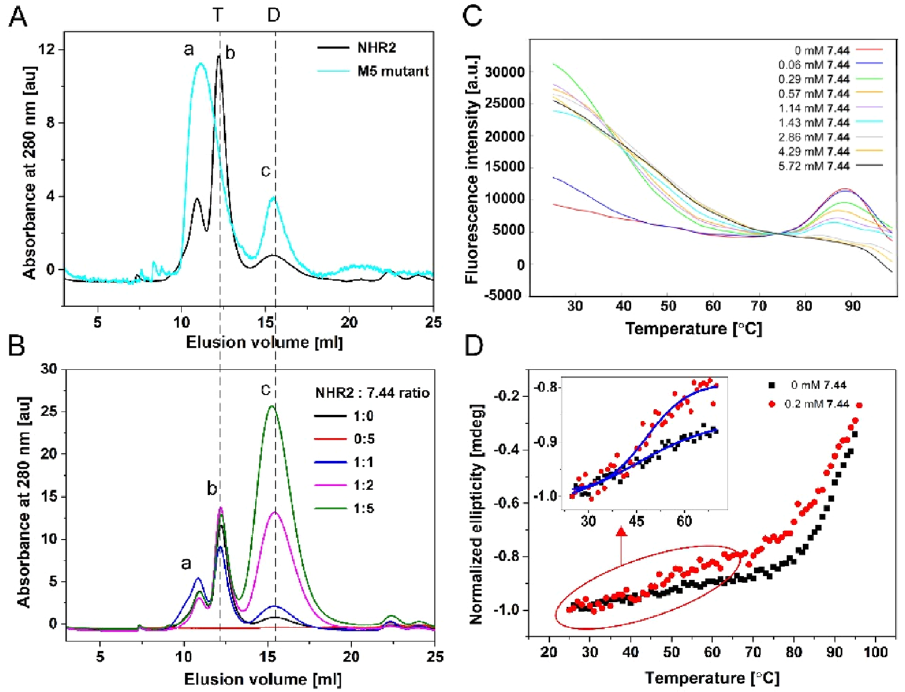
Figure 2. Stability of the NHR2 tetramer with and without 7.44 studied by size exclusion chromatography, DSF, and CD spectroscopy. ( A) Elution profiles of purified proteins of the NHR2 domain (black) and M5 variant (cyan) from size exclusion chromatography (SEC) obtained at 280 nm absorbance: higher-order oligomers (a), tetramer (b), and dimer (c). The integration of peaks (b) and (c) of the NHR2 domain yields 92% of the tetramer and 8% of the dimer. ( B) Elution profiles of 30 µM of apo NHR2 (black), 150 µM of 7.44 , and NHR2: 7.44 with molar ratios of 1:1 (blue), 1:2 (magenta), and 1:5 (green) obtained from SEC at 280 nm. Samples were incubated at 37 °C for 2 h and then incubated overnight at room temperature prior to the experiment. ( C) Fluorescence intensity in the presence of 7.44 at different concentrations; for better visualization, the curves were shifted along the y-axis to match them at the point between the two melting points of dimer and tetramer. ( D) Thermal denaturation of apo NHR2 (black) and NHR2 in the presence of 7.44 (red) monitored by CD spectroscopy at 222 nm wavelength. The CD data was normalized with respect to the highest ellipticity value for better